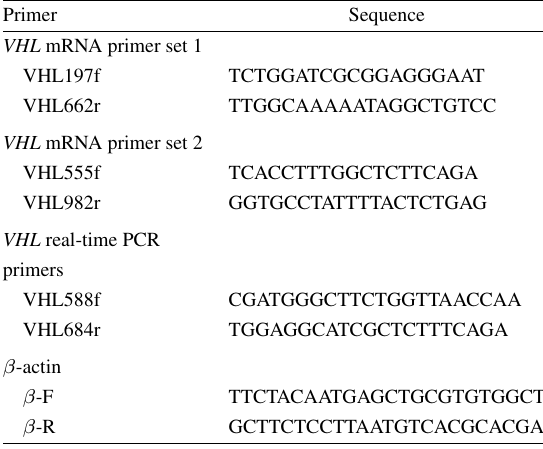
Primer sequences used for VHL mutational and transcript analysis Primer